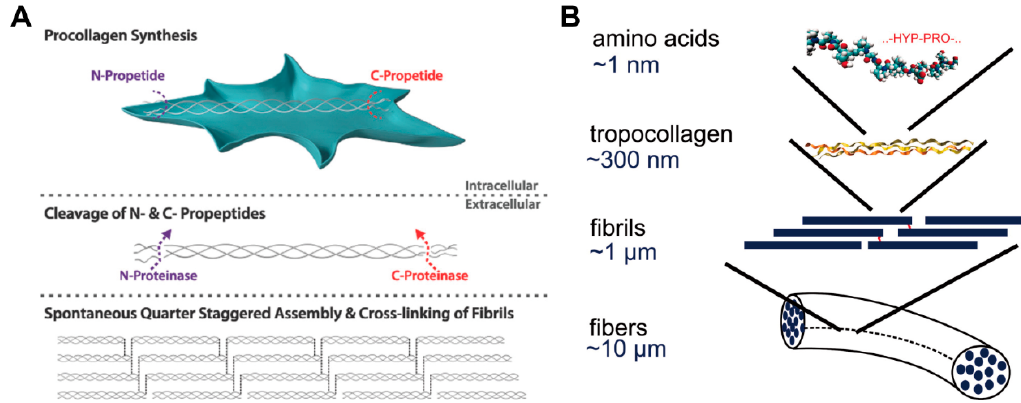
Figure 2. ( A ) Biosynthesis pathway and ( B ) hierarchical structure of collagen. Reprinted from